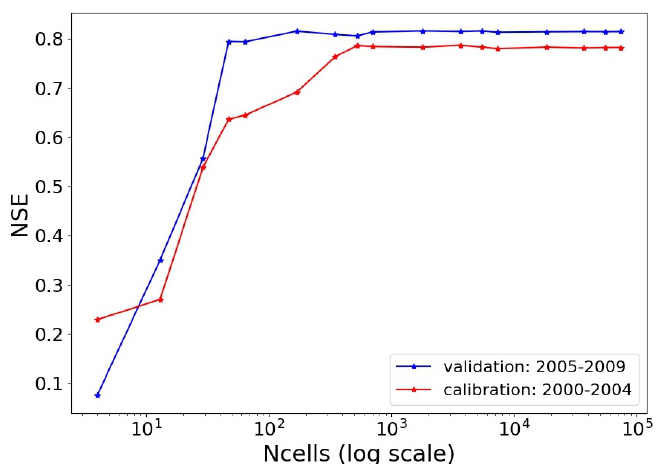
Figure 2. Scatter plot between Nash–Sutcliffe Efficiency (NSE) and number of Triangulated Irregular Network (TIN) cells